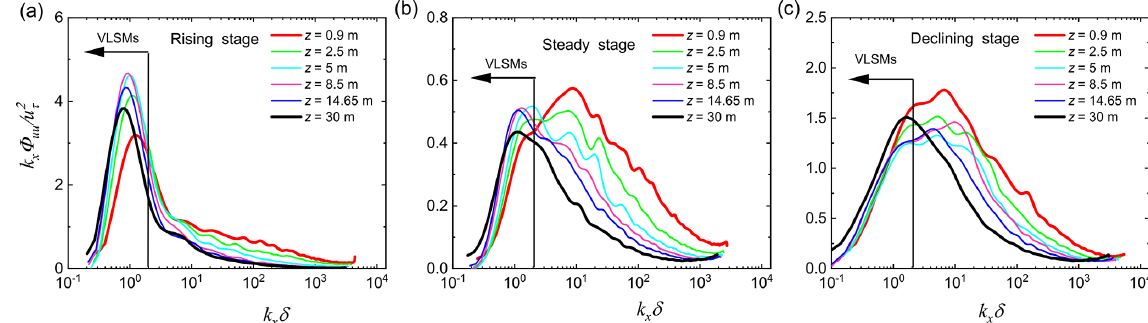
Figure 3. Pre-multiplied spectra of streamwise velocity fluctuations k x Φ uu /u 2 τ versus streamwise wavenumber k x δ , where (a) is the rising stage, (b) is the steady stage, and (c) is the declining